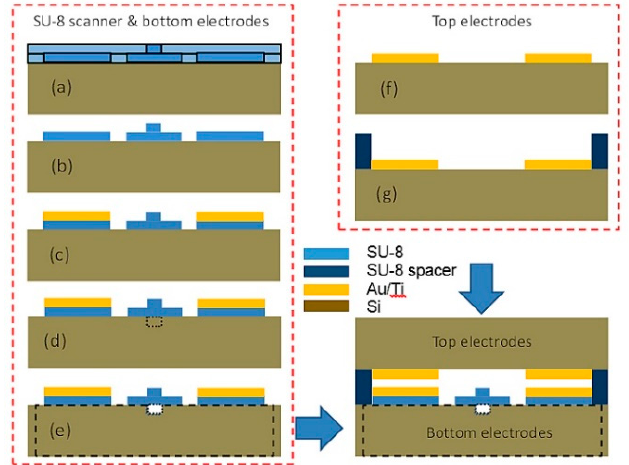
Figure 13. Fabrication process of electrostatic scanner. ( a – e ): scanner body and bottom electrodes ( f , g ): top electrodes. ( a ) Double-layer photolithography process to define rib shape waveguide and scanner pads; ( b ) Development process to create SU-8 waveguide and body; ( c ) Au / Ti thin films are deposited and patterned by lift-o ff process; ( d ) Front side fiber grooves are patterned and deep etched using deep reactive-ion etching (DRIE); ( e ) the scanner (bottom electrode and waveguide) were released by DRIE again from the backside of the wafer; ( e ) Backside etch-through to release actuators and waveguide; ( f ) top electrode is deposited and patterned on a second silicon wafer; ( g ) SU-8 spacers are spun and patterned.